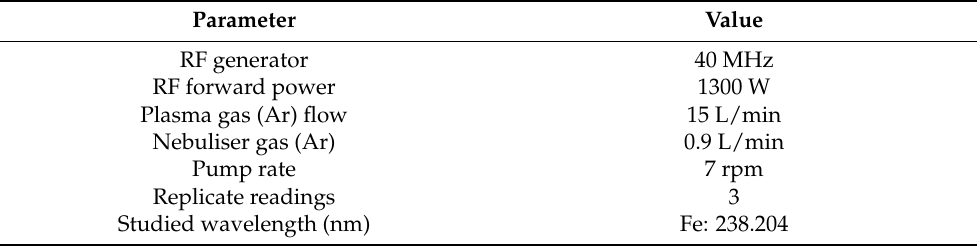
Table 2. Operational parameters of ICP-OES.